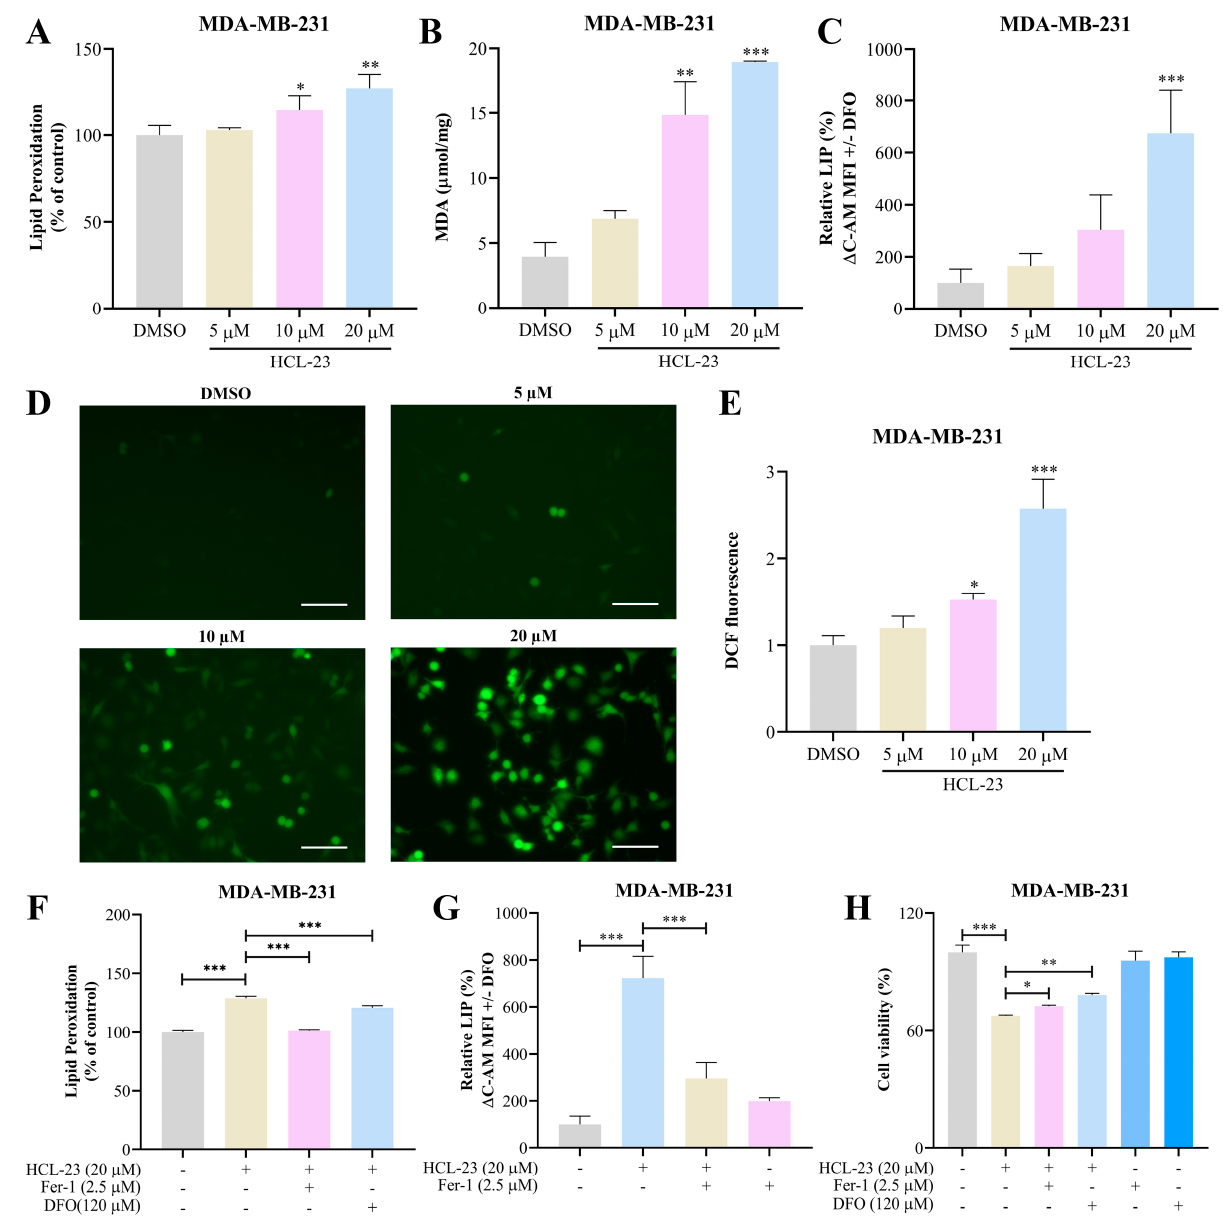
Figure 6. HCL-23 triggers ferroptosis in MDA-MB-231 cells. ( A ) Treatment with HCL-23 for 12 h increased the level of lipid peroxidation in MDA-MB-231 cells in a concentration-dependent manner. ( B ) Treatment with HCL-23 for 12 h increased the level of MDA. ( C ) Treatment with HCL-23 for 12 h increased the level of LIP. ( D ) MDA-MB-231 cells were treated with HCL-23 for 12 h and then incubated with DCFH-DA probe. ROS level was examined by fluorescence microscopy (magnification × 200; scale bar 100 µ m). ( E ) DCF fluorescence intensity was quantified by flow cytometry. ( F ) HCL-23 (20 µ M) increased the level of lipid peroxidation in MDA-MB-231 cells, which could be blocked by Fer-1 (2.5 µ M) and DFO (120 µ M). ( G ) Fer-1 (2.5 µ M) treatment eliminated the increased level of LIP induced by HCL-23 (20 µ M) in MDA-MB-231 cells. ( H ) HCL-23 (20 µ M) decreased the cell viability in MDA-MB-231 cells, but Fer-1 (2.5 µ M) and DFO (120 µ M) counteracted HCL-23-induced inhibition of cell viability. Data represent the mean ± SD of three independent experiments. * p < 0.05, ** p < 0.01, *** p <